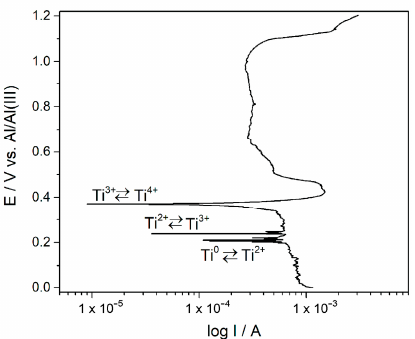
Figure 2. Potentiodynamic polarization curve of the Ti working electrode in the equimolar AlCl 3 - NaCl melt at T = 200 °C, E I = 0.0 V and E F = 1.200 V.